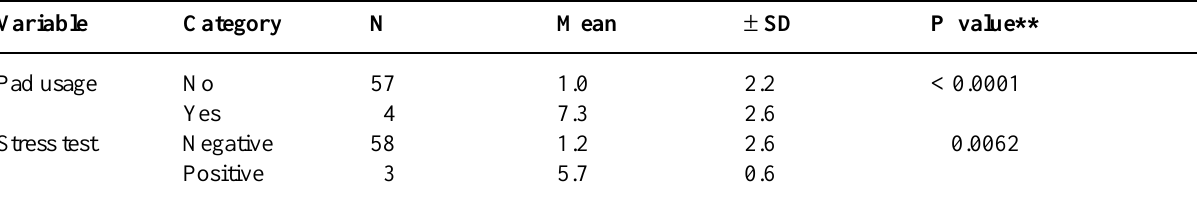
Table 3 – Study of the external responsiveness of the ICIQ-SF comparing post-treatment questionnaire final score, pad usage and